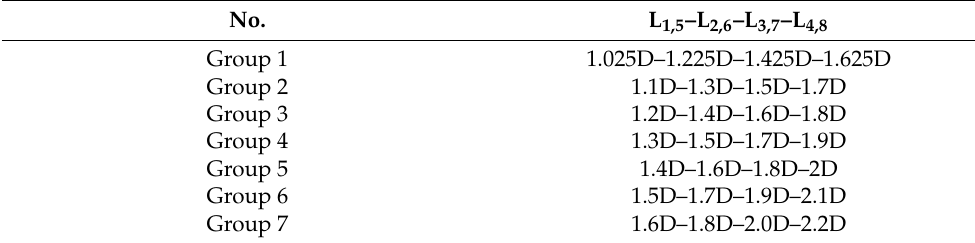
Table 2. Rotor spacing groups for V8 Octorotor